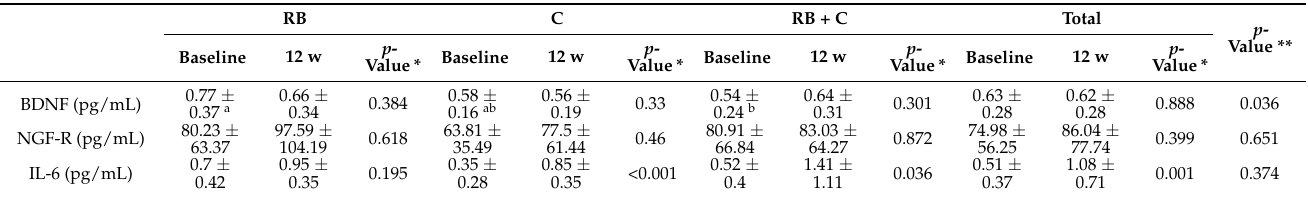
Table 6. Biochemical parameters of nerve growth and inflammation in each group and by visit.